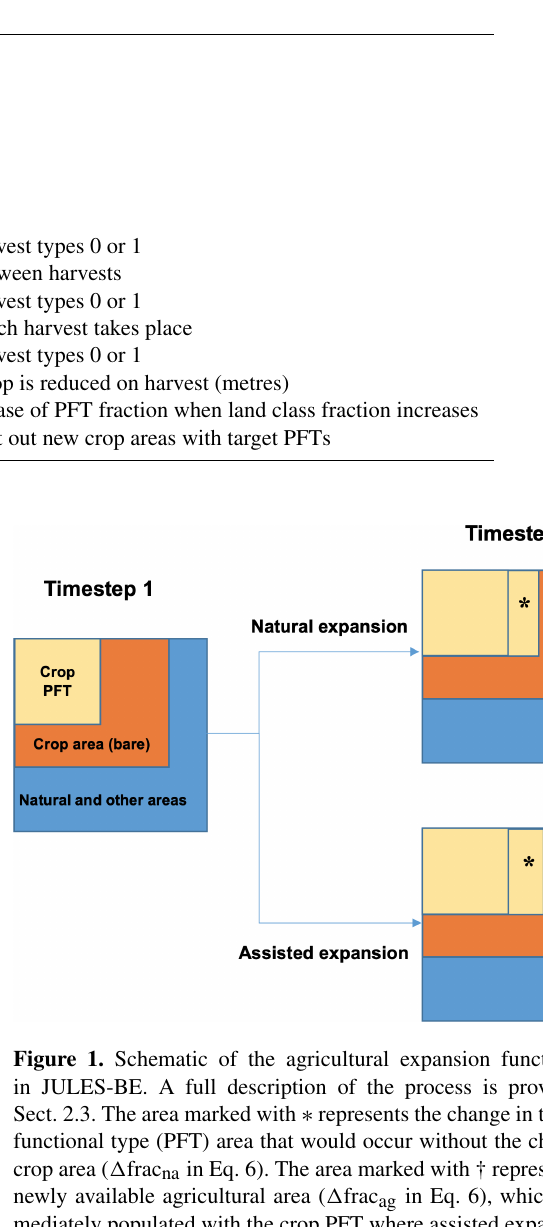
Table 2. TRIFFID parameters required for JULES-BE. An explanation of the use of these parameters is given in Sect. 2.2. Parameter